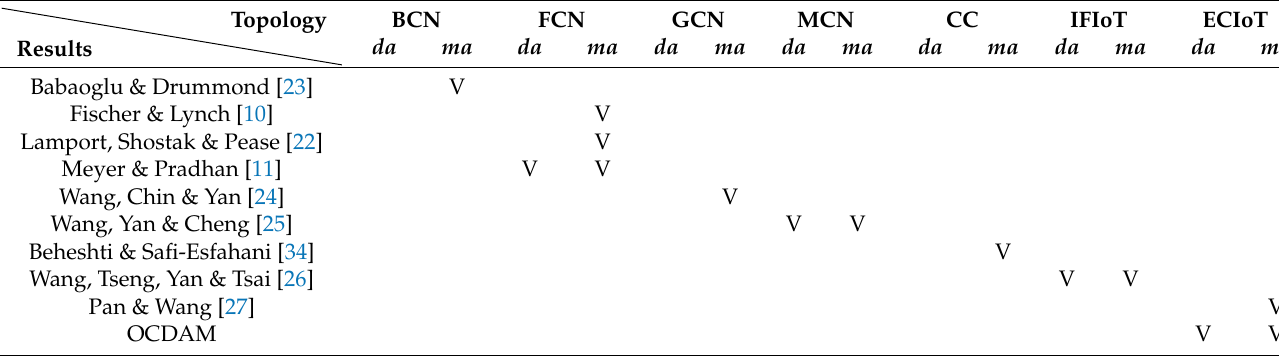
Table 1. The comparison of previous various protocols over different network models.